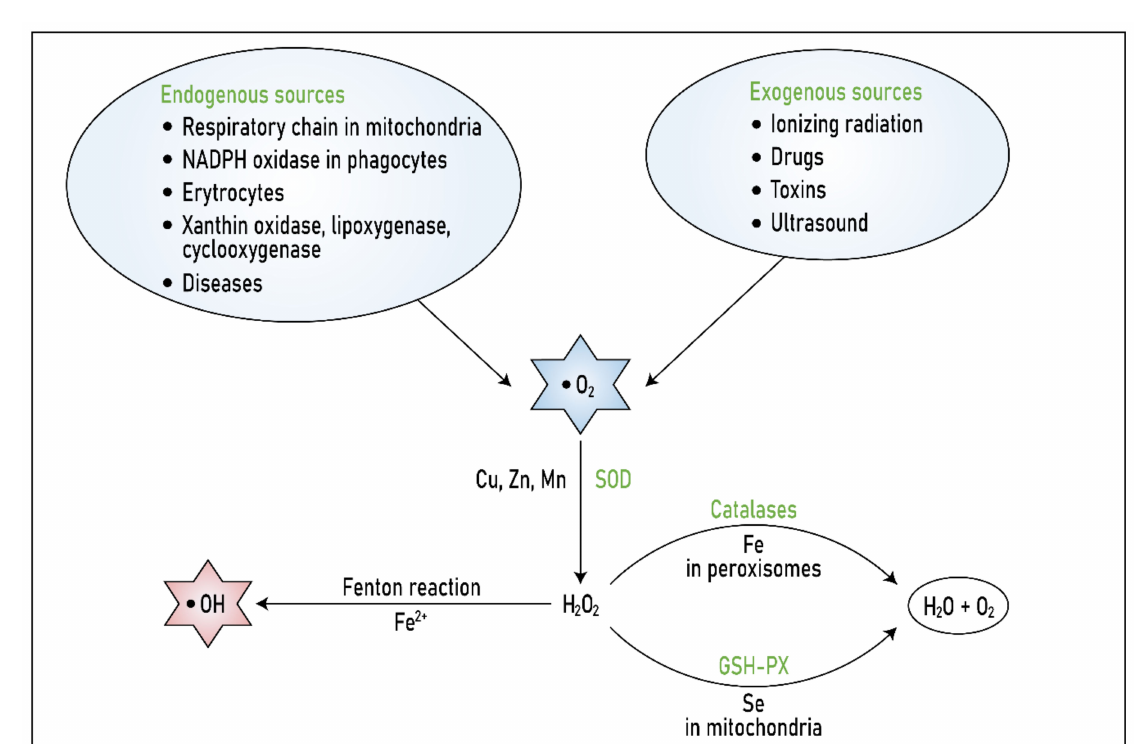
Figure 2. Relationship between the three major enzymes in the antioxidant protective system. Modified from